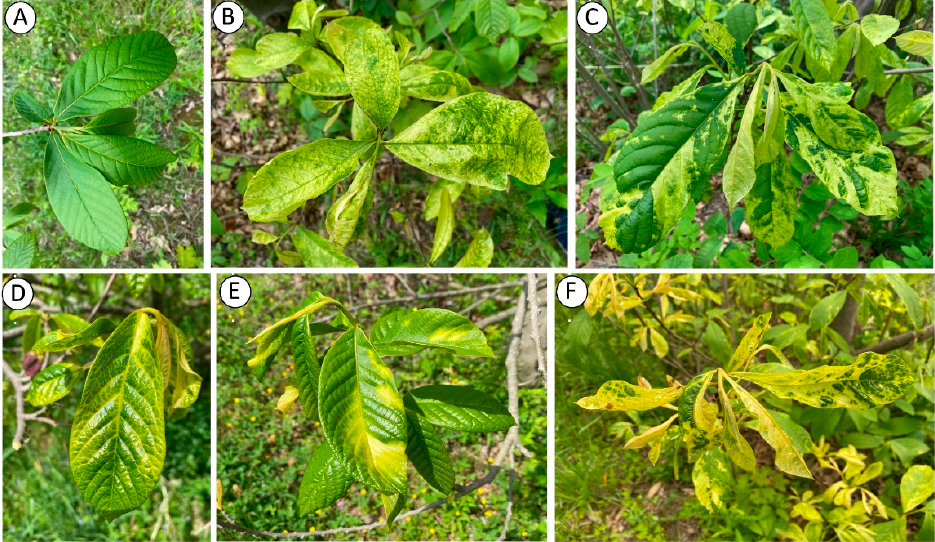
Figure 2. An asymptomatic leaf of a pawpaw tree ( A ) and foliar symptoms of discoloration ( B ), mosaic and distortion ( C ), vein clearing ( D ), patchy chlorosis ( E ), and chlorosis and distortion on pawpaw trees or saplings ( F ) in an experimental orchard in Lansing, NY. Photos were taken in May 2022.